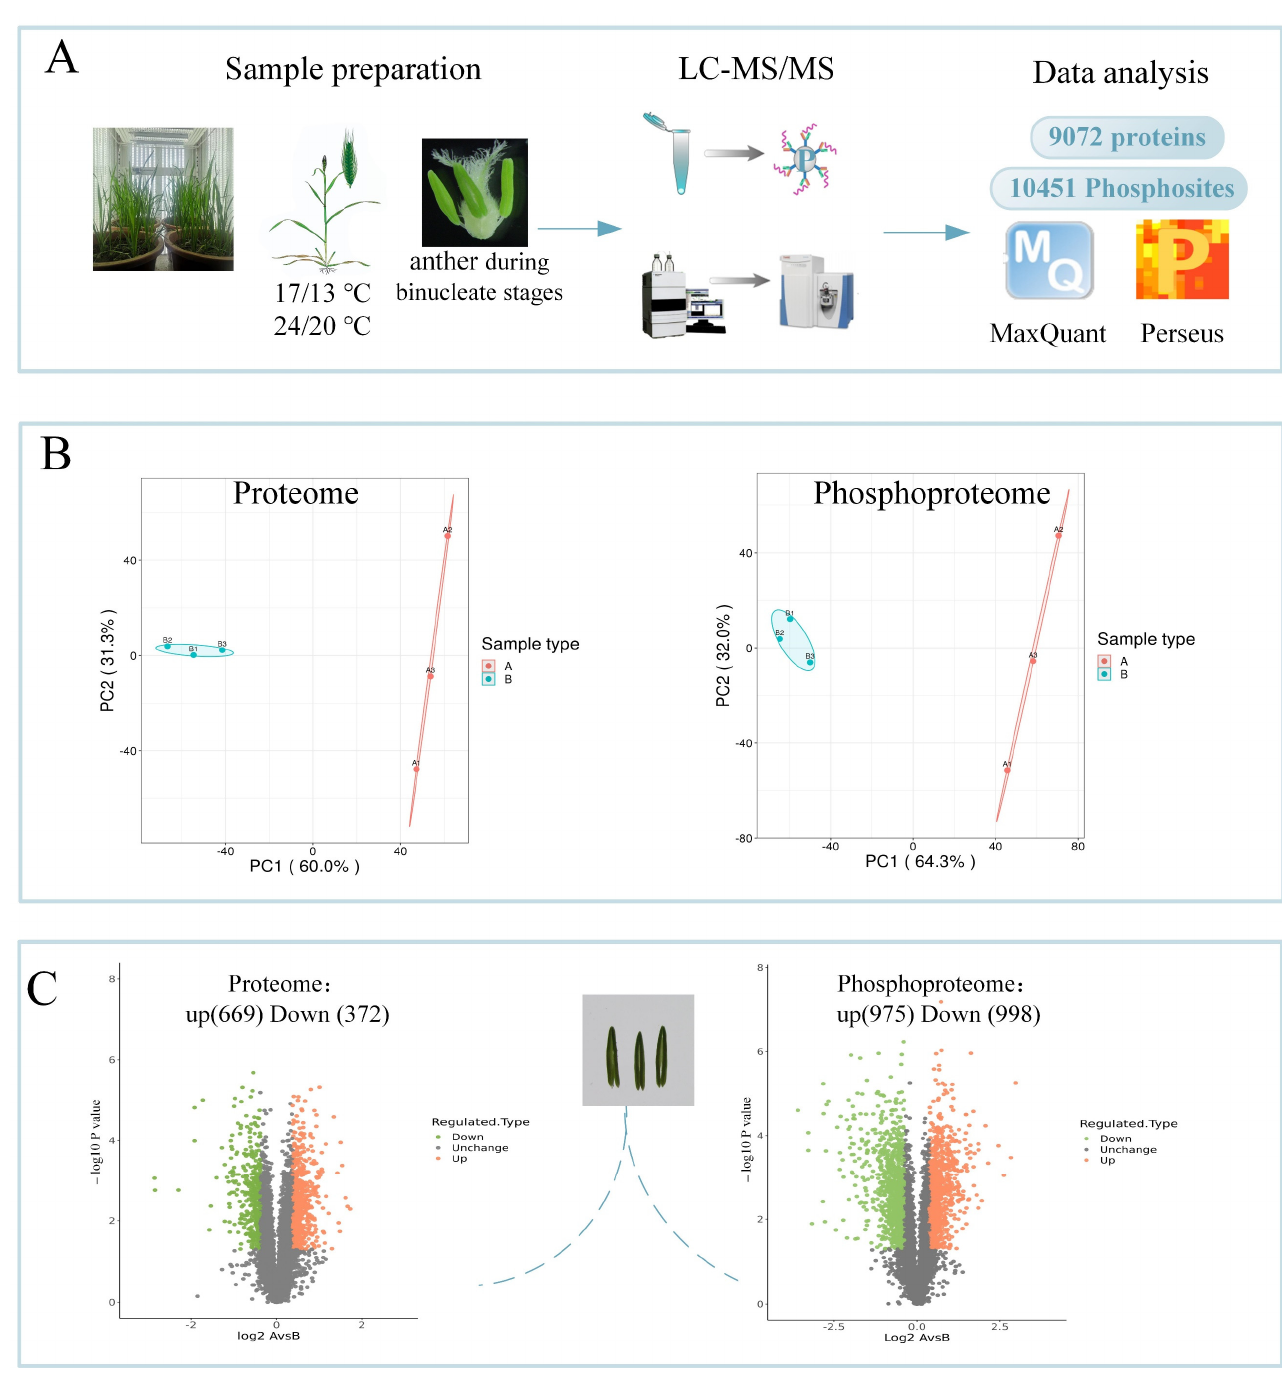
Figure 2. Experimental strategy. ( A ) Sample preparation and workflow of the integrated proteomic and phosphoproteomic analyses. ( B ) Scatter plot of quantitative principal component analysis between repeated samples in the proteome and phosphoproteome data. ( C ) Up- and down-regulated proteins and phosphosites that were statistically significant are represented in the scatter plots. Each point represents a protein or a phosphosite.